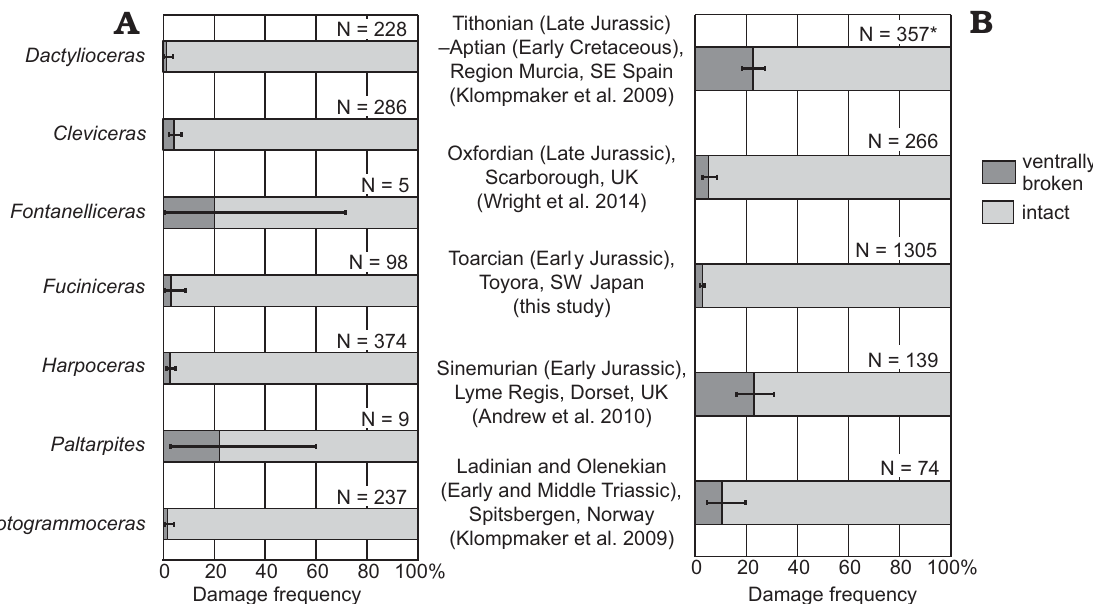
Fig. 9. Frequency of occurrence of lethal ventral damage on ammonoid shells. Error bars represent 95% binomial confidence intervals. A . Lower Taxon Frequency for the specimens of 7 genera from the Toyora area (see also Table 1). B . Assemblage Frequency for the selected Mesozoic ammonoid samples from different ages and/or regions. * The number is based on near-complete